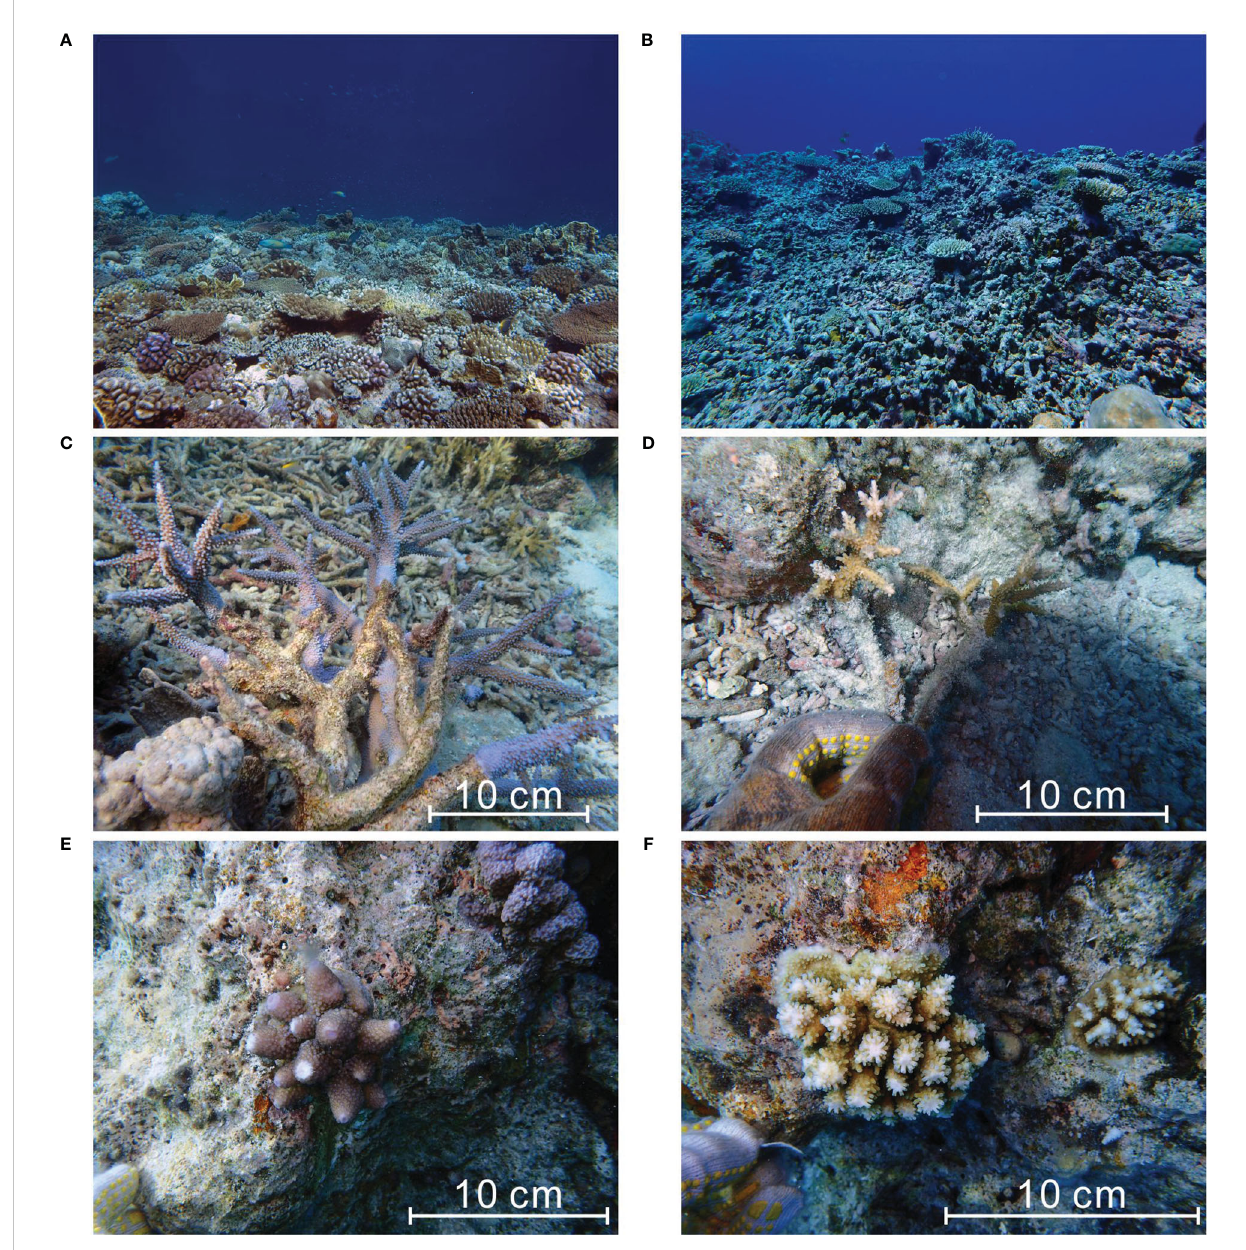
FIGURE 10 Historical ( A ; photographed by T. Chen in 2007) vs. modern ( B ; photographed by T. Chen in 2017) coral communities at the reef slope (MJ-2). Diverse recovery modes of the fast-growing Acropora population, including (C) rapid regeneration of remnant surviving tissue, (D) reproduction by asexual fragmentation, and (E, F) replenishment of juvenile colonies by larvae, were ubiquitous at the sampling sites (photographed by T. Chen). The massive loss of the adult corals, and subsequent shift to the small colonies-dominated or even rubble-dominated states have drastically altered the reef morphology and may further impact the ecological function of coral